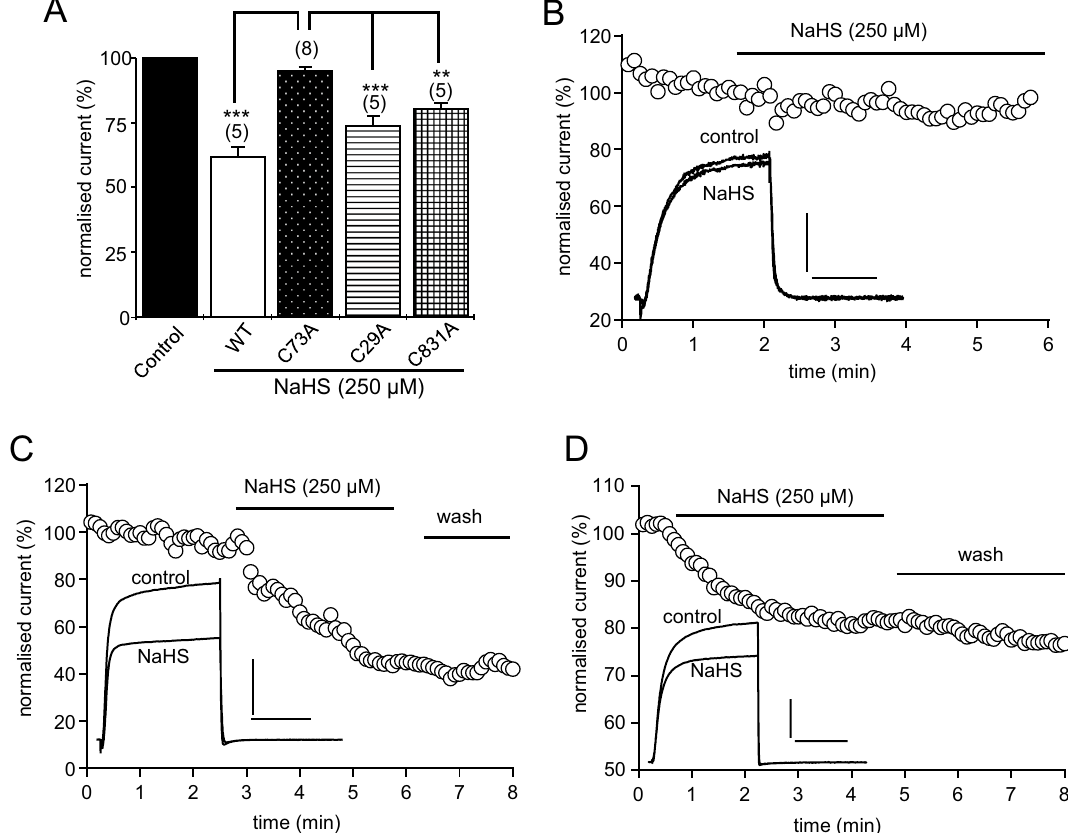
Figure 3. H 2 S does not inhibit Kv2.1 C73A but inhibit other recombinant mutant forms. ( A ) Bar graph showing normalised mean (± s.e.m.) effect of NaHS in wild-type (WT), C73A, C29A and C831A mutants of Kv2.1, as indicated (**indicates P < 0.01 and ***indicates P < 0.001 with the number of cells tested in parentheses). ( B ) Example time-series plot illustrating normalized current amplitudes evoked by step- depolarizations from − 70 to + 50 mV in a C73A Kv2.1-expressing HEK293 cell. For the period indicated by the horizontal bar, NaHS (250 µM) was applied via the perfusate. Inset shows example currents before and during NaHS application, as indicated. ( C ) Example time-series plot as in ( B ) for C29A Kv2.1-expressing HEK293 cell. For the period indicated by the horizontal bar, NaHS (250 µM) was applied via the perfusate, with irreversible effect upon washout for the time period indicated by the horizontal bar. Inset shows example currents before and during NaHS application for C29A, as indicated. ( D ) Same as in ( B and C ) except the example time-series plot illustrating a C831A Kv2.1-expressing HEK293 cell before and during application of NaHS (250 µM) for the period indicated by the horizontal bar, as in ( C ) the effect was irreversible upon washout, indicated by the horizontal bar. Inset shows example currents before and during NaHS application for C831A. Scale bars: 0.5 nA (vertical) and 50 ms